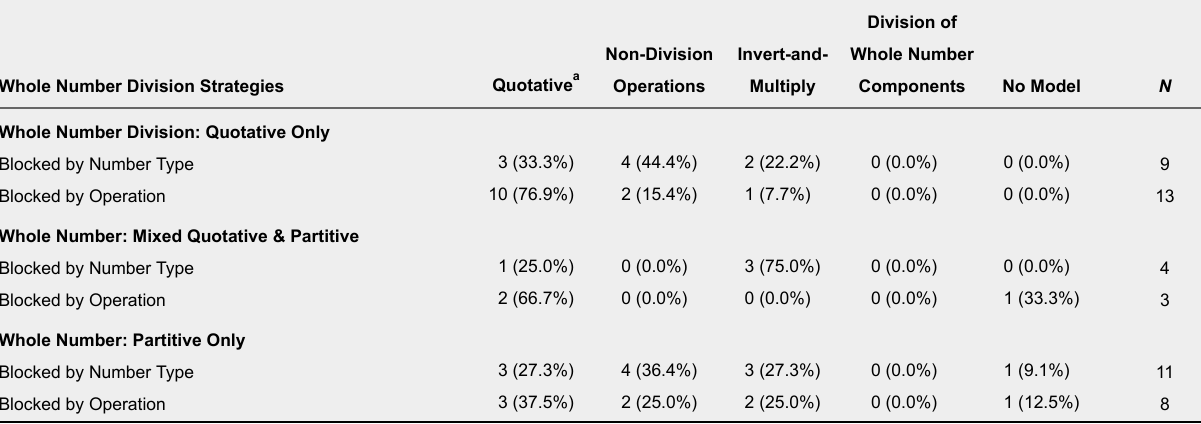
Dominant Fraction Division Strategies by Whole Number